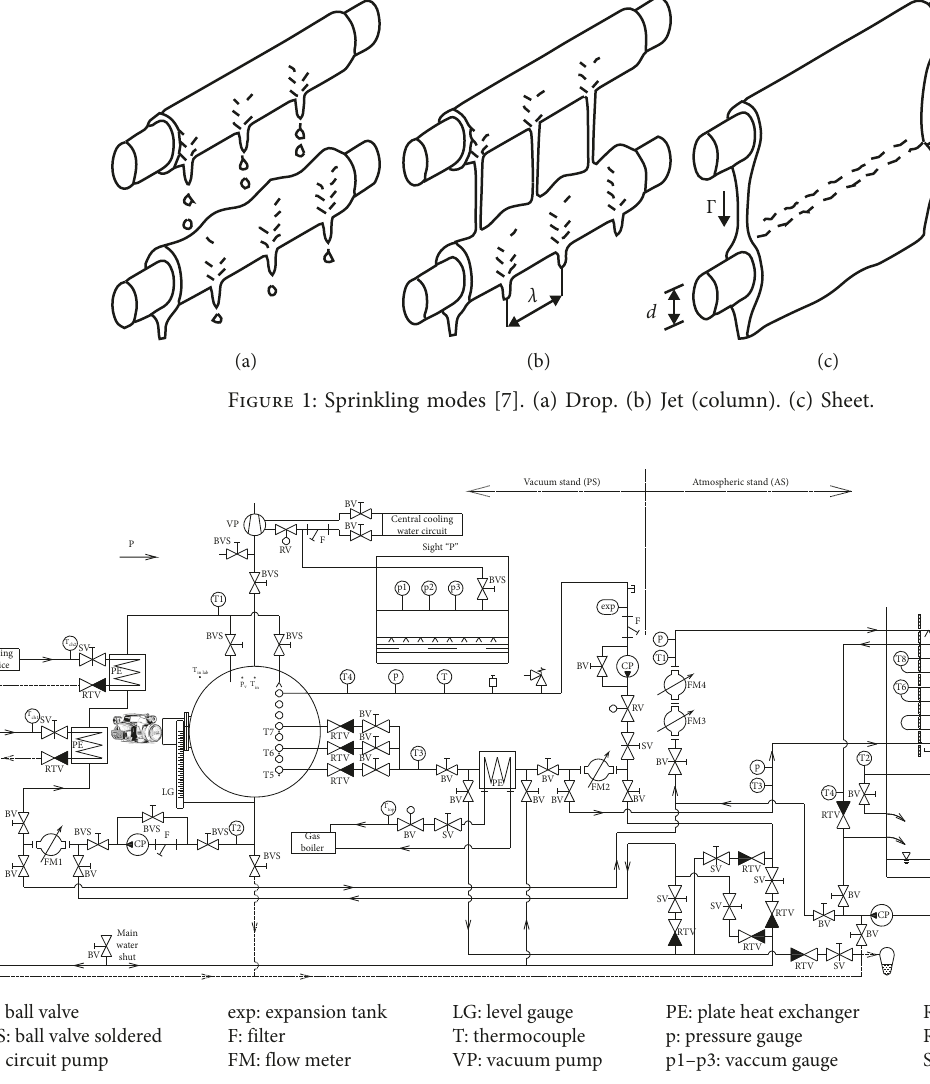
Figure 2: Simplified diagram of the experimental device with description of measured